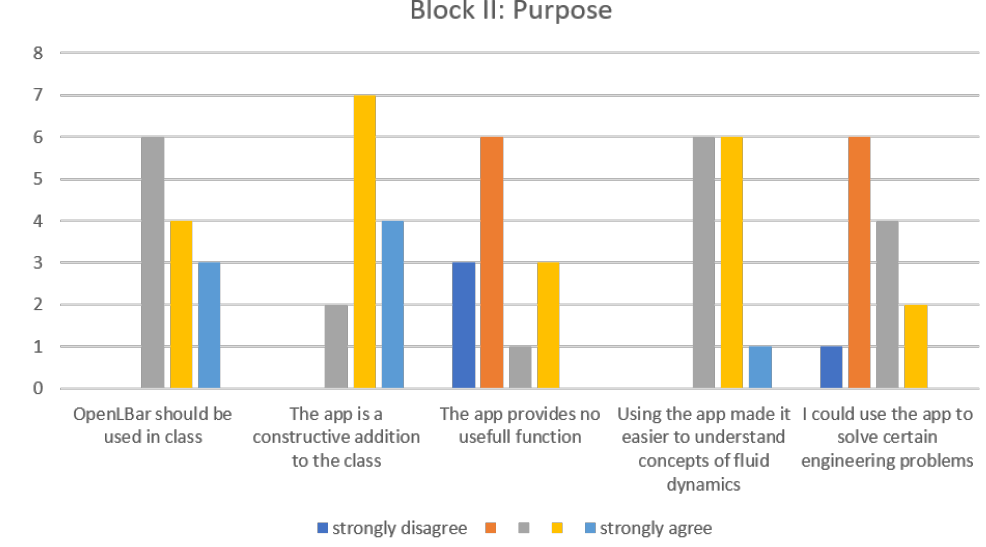
Figure 20. Second set of questions regarding the purpose of